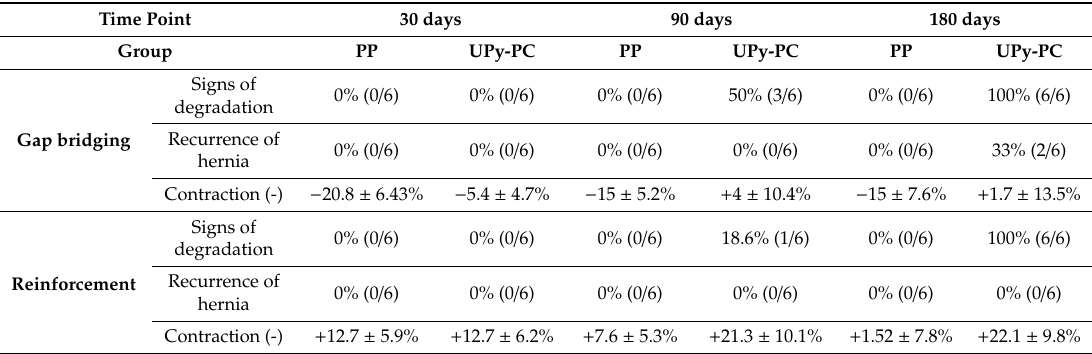
Table 2. Gross anatomy of gap bridging and reinforcement surgical sites in the polypropylene (PP) and Ureidopyrimidinone-polycarbonate (UPy-PC) group. Percentages of contraction are displayed as mean ±